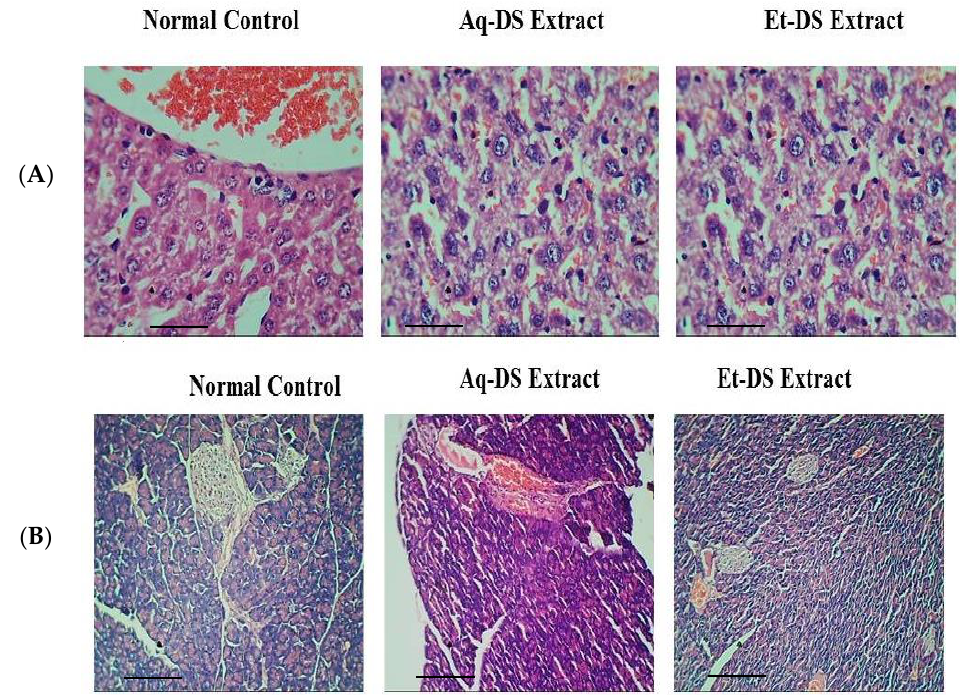
Figure 2. Histopathological photomicrographs of normal control, Aq-DS (aqueous extract of DS group) and Et-DS (ethanolic extract of DS group) extracts administered at 500 mg/kg, single dose in ( A ) Liver, normal hepatic cells and well-preserved cell organelles without pathological alterations are evident in Hematoxylin and Eosin stained sections (5 µm thick) at 40× magnification; ( B ) Pancreas, normal islets of Langerhans without pathological alterations are evident in Hematoxylin and Eosin stained sections at 10×. Scale Bars: ( A , B ) = 0.2 cm.